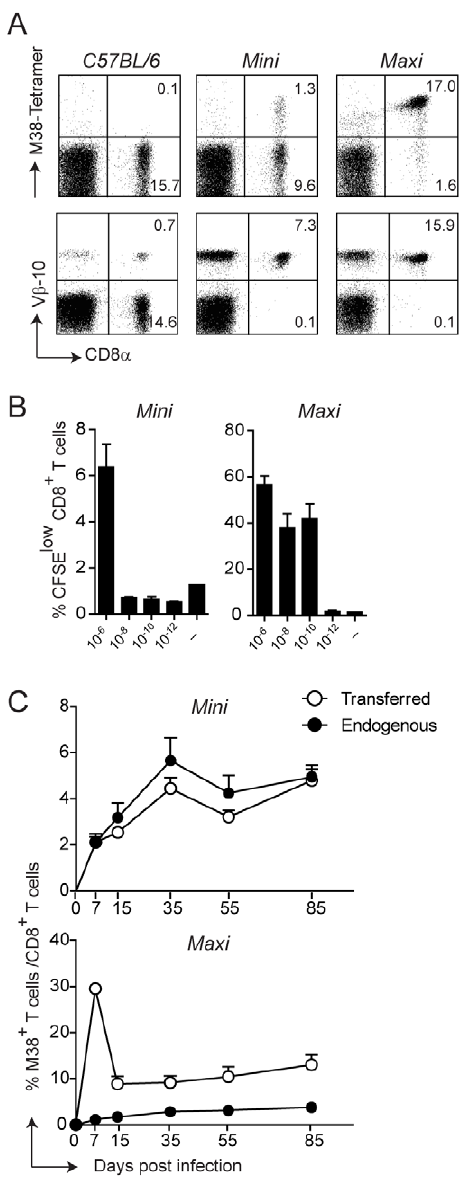
Figure 2. Generation of MHC class I-restricted TCR transgenic mice with specificity for the M38 epitope of MCMV. (A) Splenocytes from WT C57BL/6 mice and from the transgenic mouse lines Mini and Maxi were stained with M38-tetramer (top panels) and with anti-V b 10 antibody (lower panels). Percentages of CD8 + M38 + and CD8 + V b 10 + are depicted in the plots and are representative of at least 10 individual mice. (B) 6 6 10 5 Mini CD8 T cells and 6 6 10 4 Maxi CD8 T cells were CFSE labeled and incubated with DCs loaded with the indicated concentration of M38 peptide or with medium for three days. The percentages of CFSE low cells are depicted. Bars show averages of three mice per group 6 SEM, and one of two independent experiments is shown as representative. (C) 10 5 Mini CD8 T cells or 10 4 Maxi CD8 T cells expressing the CD45.1 congenic marker were adoptively transferred into CD45.2 recipient C57BL/6 mice one day prior to infection with MCMV. The percentages of endogenous (black circles) and transferred (white circles) M38-specific CD8 T cells were measured by tetramer staining from blood samples collected at the indicated time points after infection. Each point shows the average of three to five mice per group 6 SEM. One of at least five (for Mini CD8 T cells) and two (for Maxi CD8 T cells) independent experiments are shown as representative.